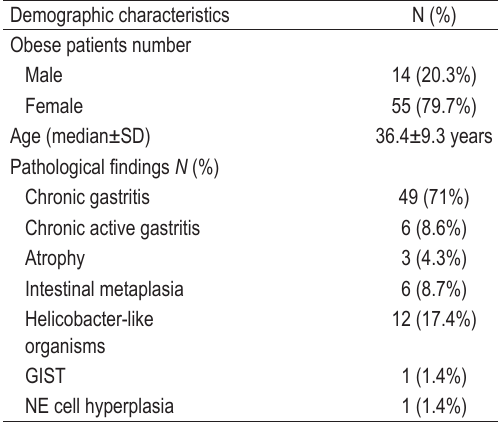
TABLE 1. Demographic and clinicopathological features of LSG